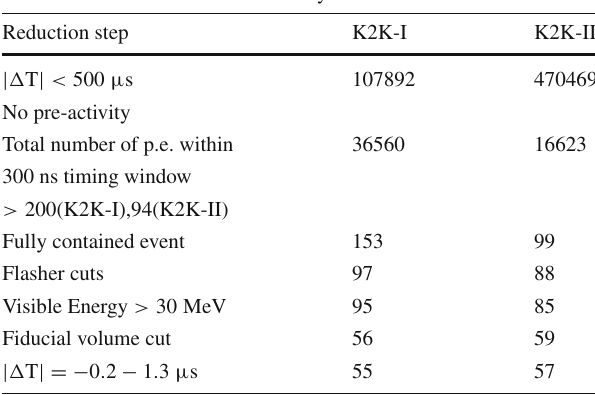
Table 6 SK event reduction